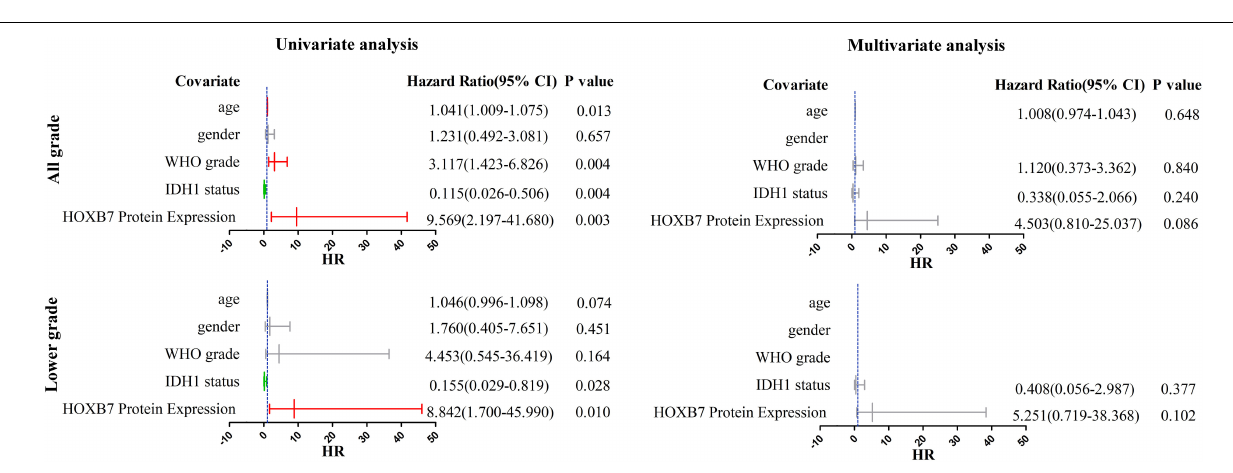
FIGURE 5 | Univariate and multivariate analyses for OS in Ditan Hospital cohort (CI, confidence interval).